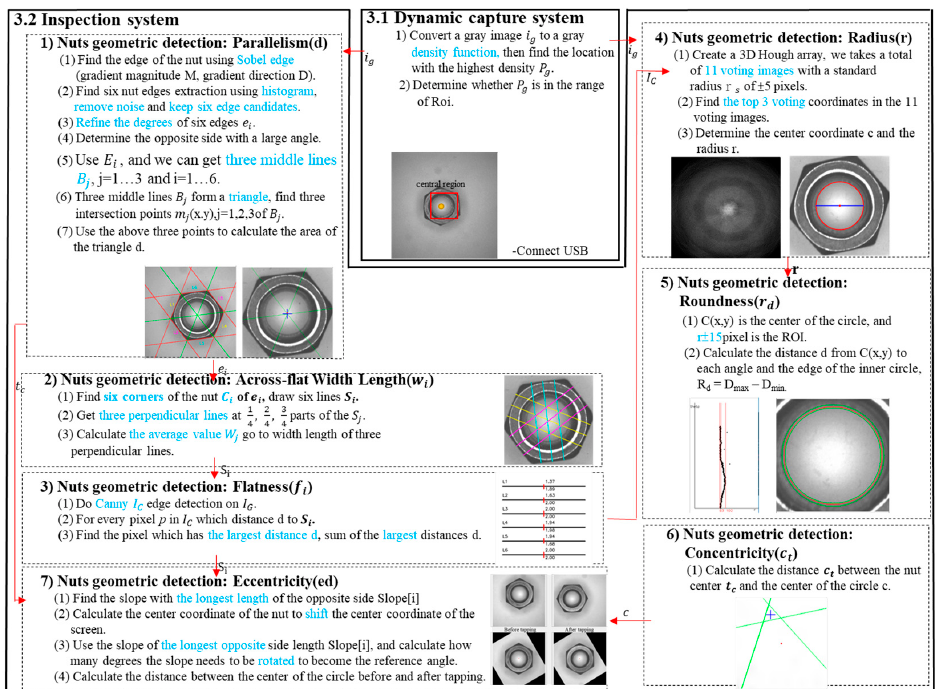
Figure 3. System Figure 3. System framework.